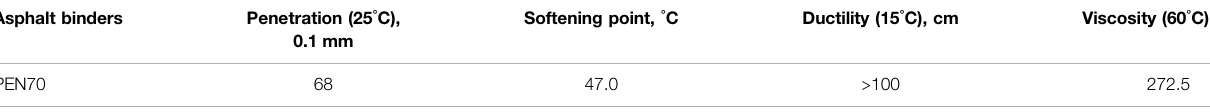
TABLE 1 | Properties of PEN70 asphalt binder. Asphalt binders